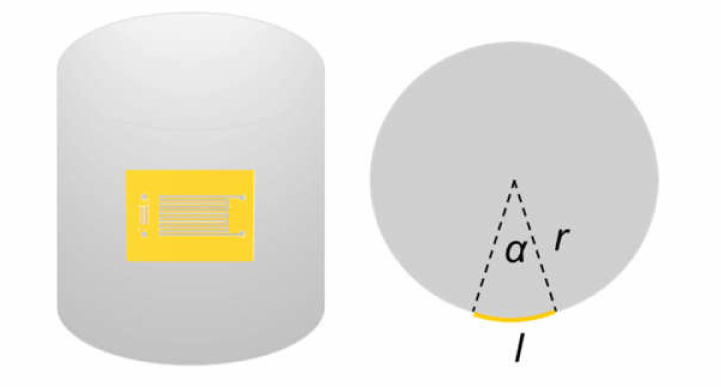
Figure 2. Schematic diagram showing how the bending angle is calculated.